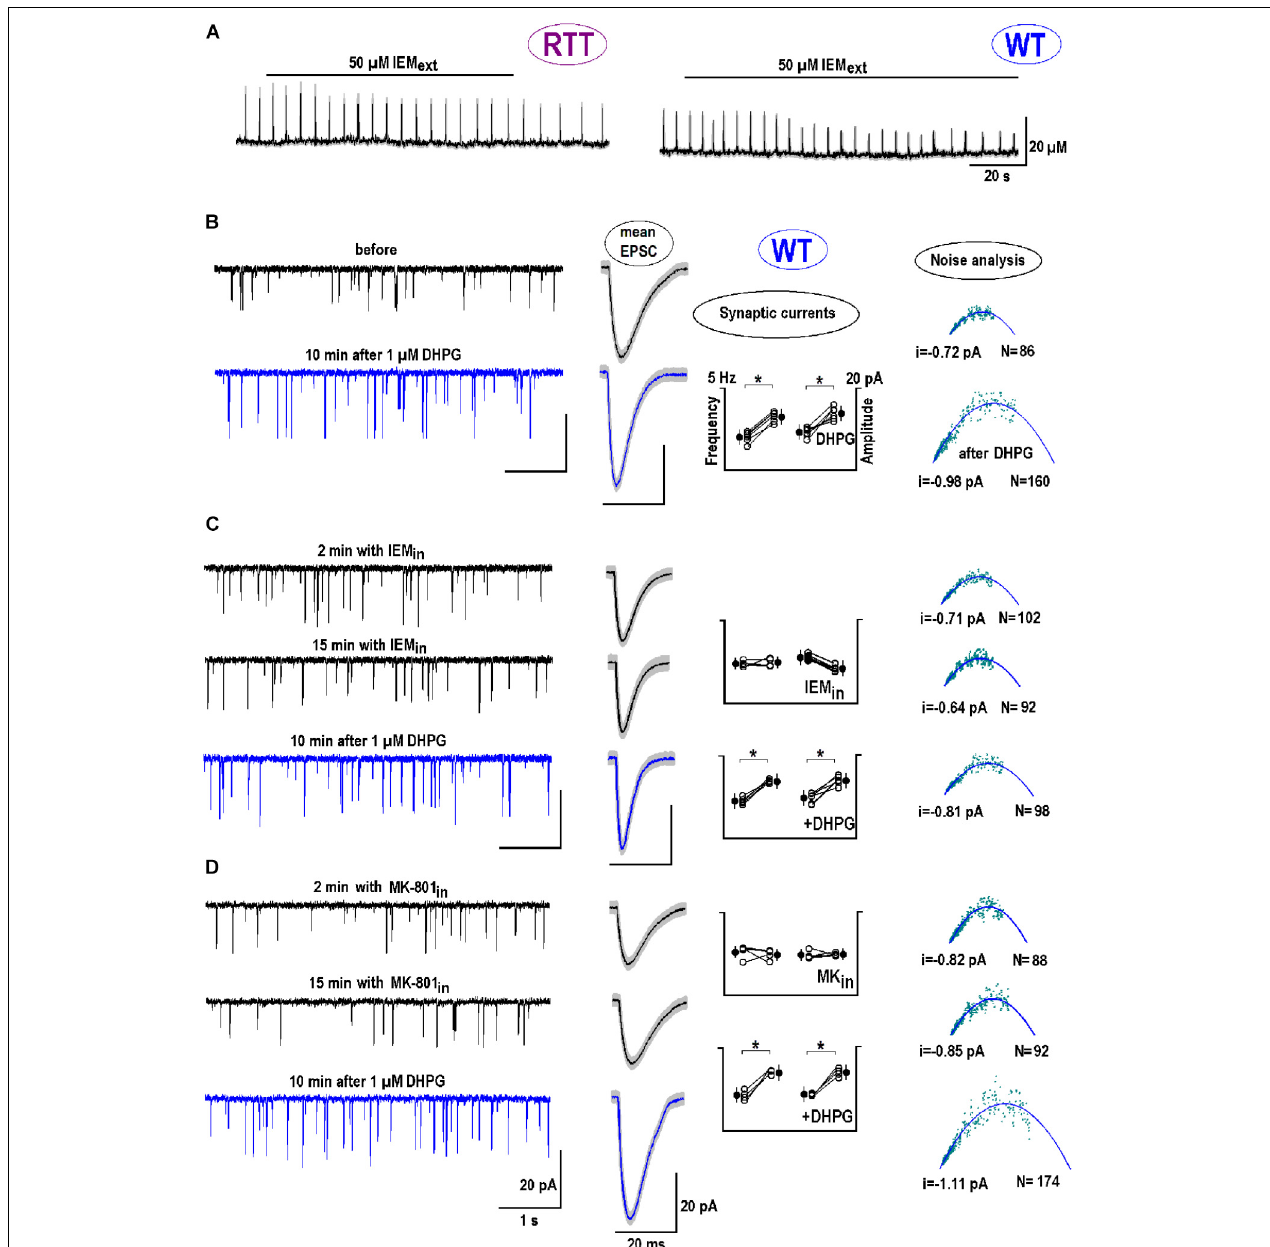
FIGURE 7 | The postsynaptic effects of DHPG: Calcium-permeable (CP)-AMPAR channels. (A) Bath application of CP-AMPAR antagonist IEM-1925 (50 µ M) depressed glutamate spikes in RTT (spontaneous, the left trace) and WT (DHPG-induced, the right trace). (B) The two traces on the left show sample EPSC recordings in WT before and 10 min after DHPG (1 µ M for 30 s). The next two smooth traces are mean EPSCs obtained from 30 single events and overlaid upon SEM (a gray background). Next is a group summary for changes in frequency ( f ) and amplitude ( A ) of synaptic currents due to DHPG. The last column presents a non-stationary noise EPSC analysis (see section “Materials and Methods” for details). The outcome was the single channel current ( i ) and the number of channels ( N ) at the postsynapse. From the pool of data sampled in one neuron, we potted the variance ( σ 2 ) against mean current ( I ). Mean-square fitting of σ 2 - I plots by parabolas returned mean i and N values at the “‘average” postsynapse. All data were evaluated with Student’s t -test with confidence levels of p < 0.05 ( ∗ ). The data in panel (B) serves as a “control” of DHPG effects and shows significant changes in all parameters ( f and A , i and N ; n = 6, p < 0.05). (C,D) The neurons were patched in other and internally perfused with the antagonists to CP-AMPAR (50 µ M IEM-1925, C ) and NMDAR (10 µ M MK-801, D ), respectively. DHPG was then applied for 15 min. (C) Cytoplasmic IEM decreased did not change f and A , i and N significantly ( p < 0.05, n = 4). After DHPG both f and A significantly changed ( p < 0.05), but i and N were not markedly modified ( P > 0.1, Mann–Whitney U test). (D) Cytoplasmic MK-801 did not change f and A , i and N ( p > 0.1, n = 4). The effects of DHPG in this case were around the same as in the control ( P > 0.1, Mann–Whitney U test). Supplementary Figure S3 shows the postsynaptic changes in WT and RTT after stimulation of ionotropic GluR